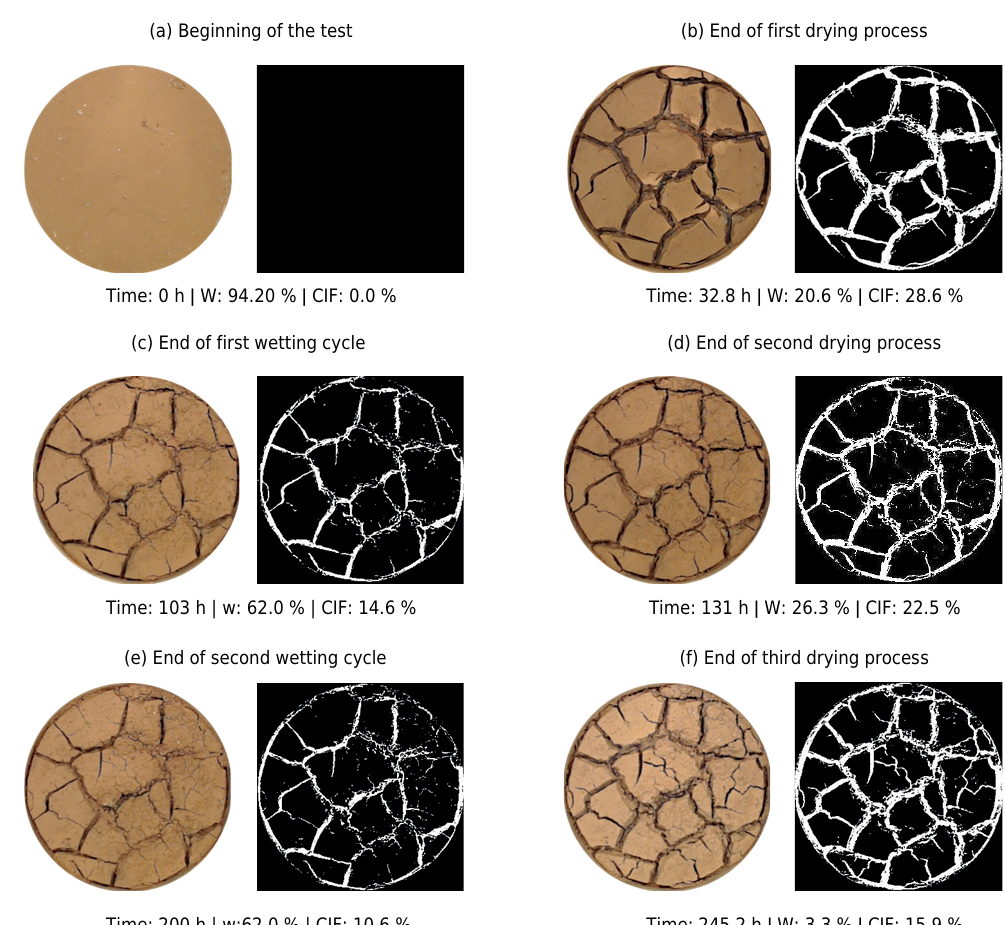
Figure 5. Comparison of images of the cracking process at the beginning and end of each cycle –